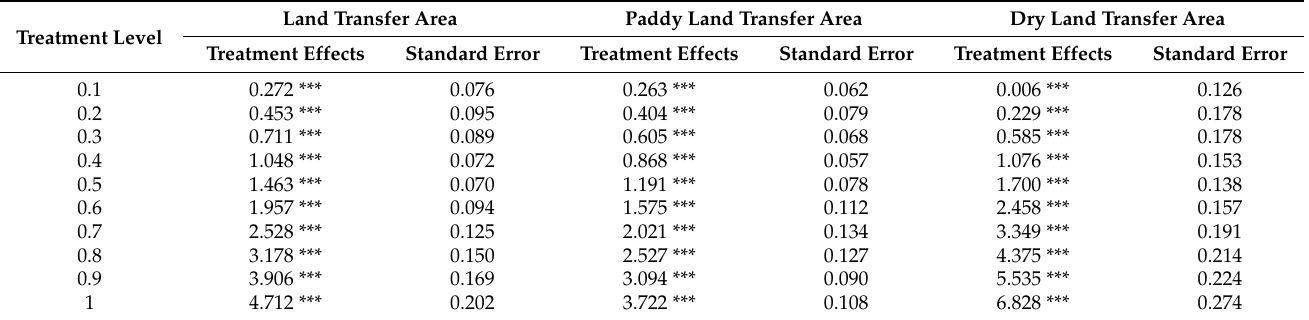
Table 6. GSPM estimation of types of land transfer area on the proportion of non-farm employment personnel in farm